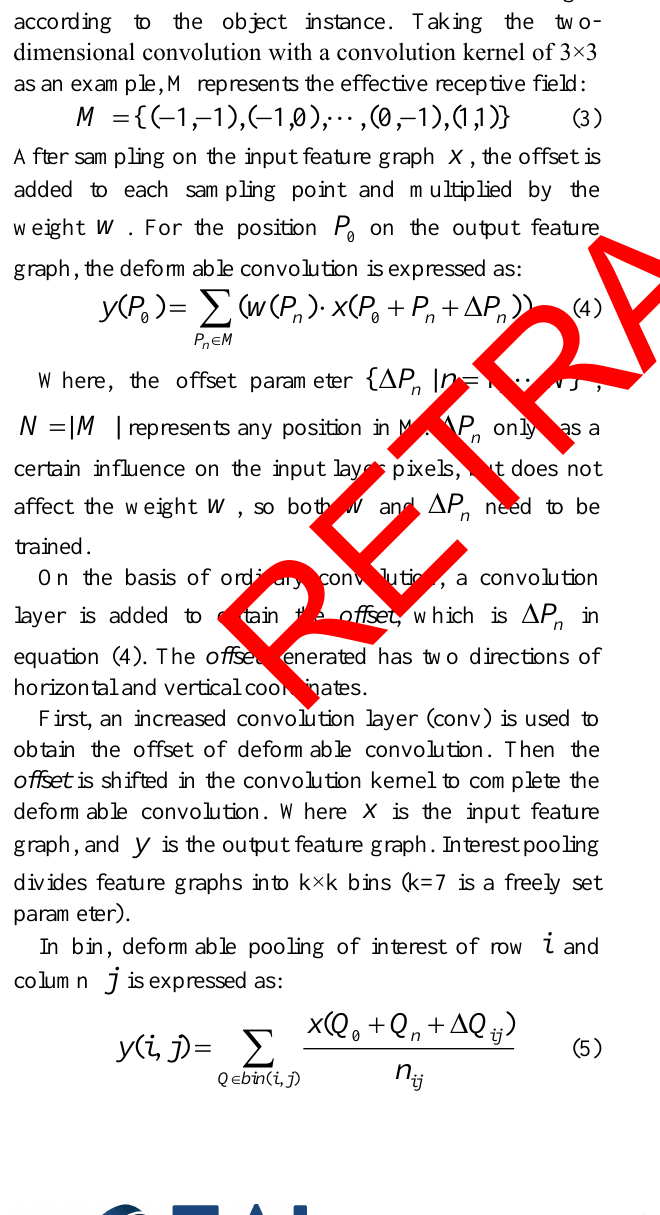
Figure 2. Structure of deformable pool of interest